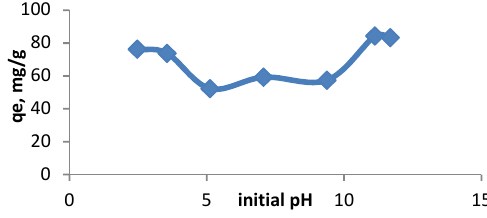
Fig.4a. Effect of pH of solution on dye uptake of MB on